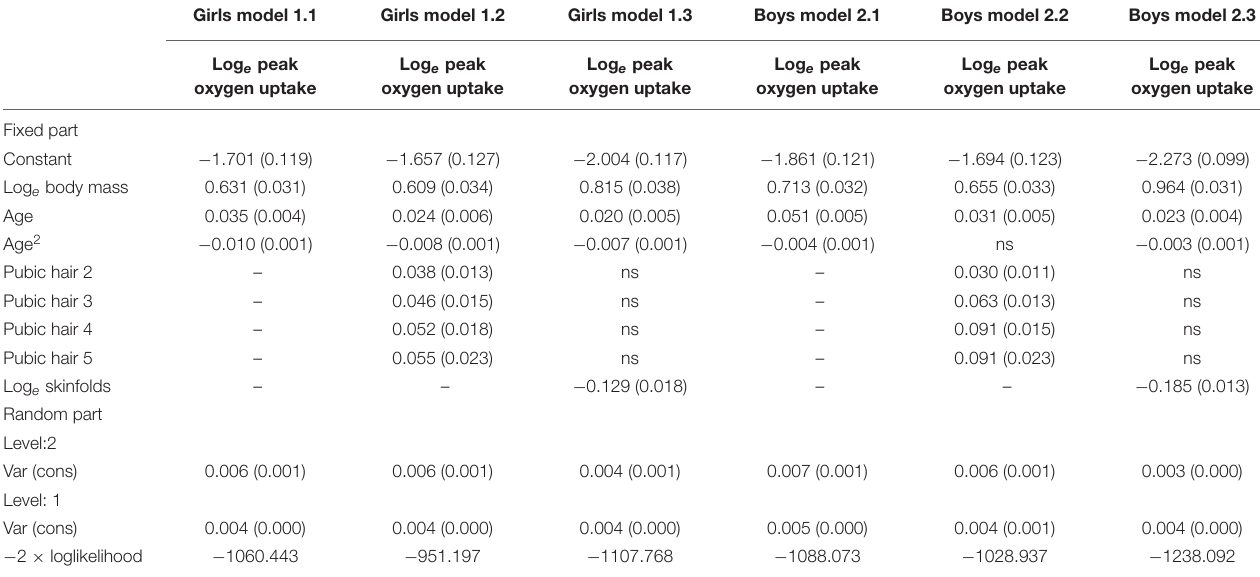
TABLE 1 | Multilevel regression models for peak oxygen